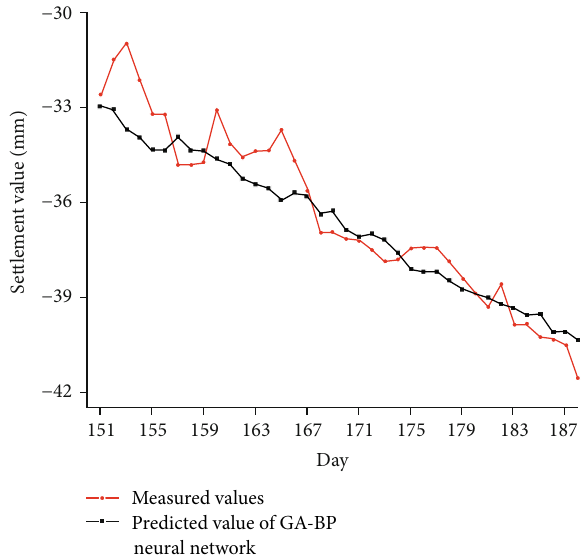
Figure 6: The comparison between measured values and predicted value of GA-BP neural network.